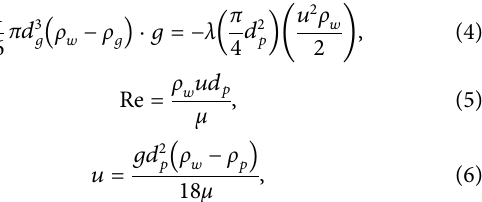
Frontiers in Environmental Science |